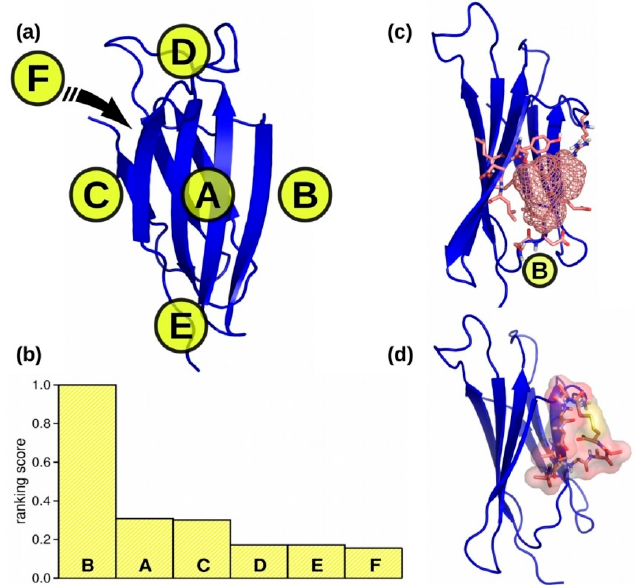
Figure 2. (a ) Definition of the different regions in β 2m for the classification of the binding sites identified by PeptiMap, each region is identified by a capital letter, ( b ) averaged binding sites ranking scores for each region as labelled in panel a, and ( c ) the β 2m region B formed by the residues S34, D35, I36, E37, V38, R46, S53, D54, L55, L65, and Y67. ( d ) Starting structure of the cyclic dodecapeptide polyalanine bound to the β 2m region B.